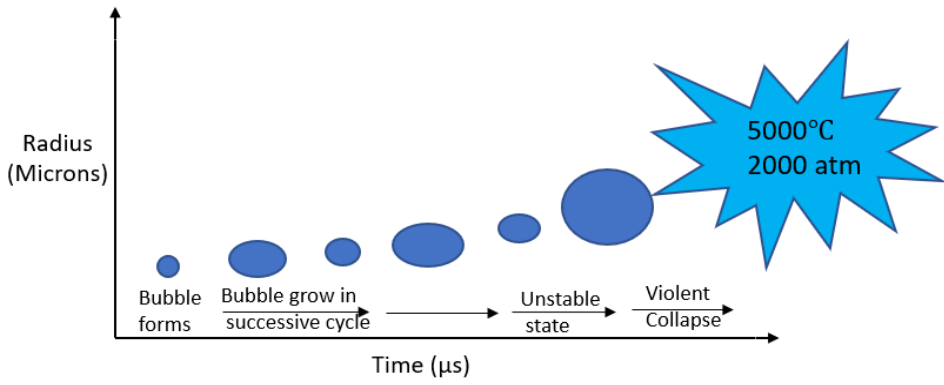
Figure 1. The evolution of a cavitation bubble during ultrasonication.